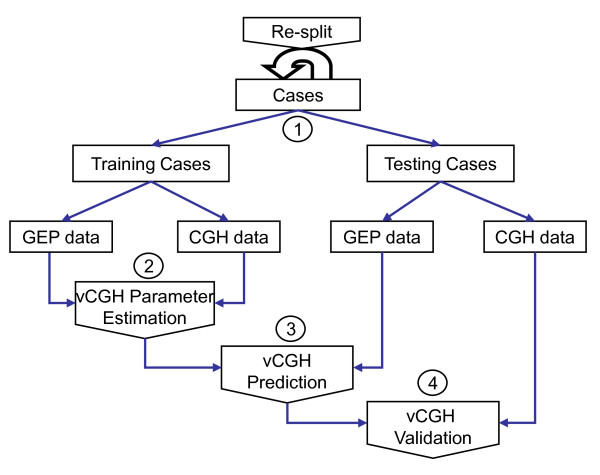
Procedure of vCGH training and validation. The entire dataset was split into training and testing datasets. In the training dataset, the paired GEP and CGH data were used for model parameter estimation; in the testing dataset, only the GEP data was used for vCGH prediction and the corresponding CGH data was used for validating vCGH prediction. The whole process was repeated by different splitting of training and testing datasets and the model performance was evaluated by LOOCV.